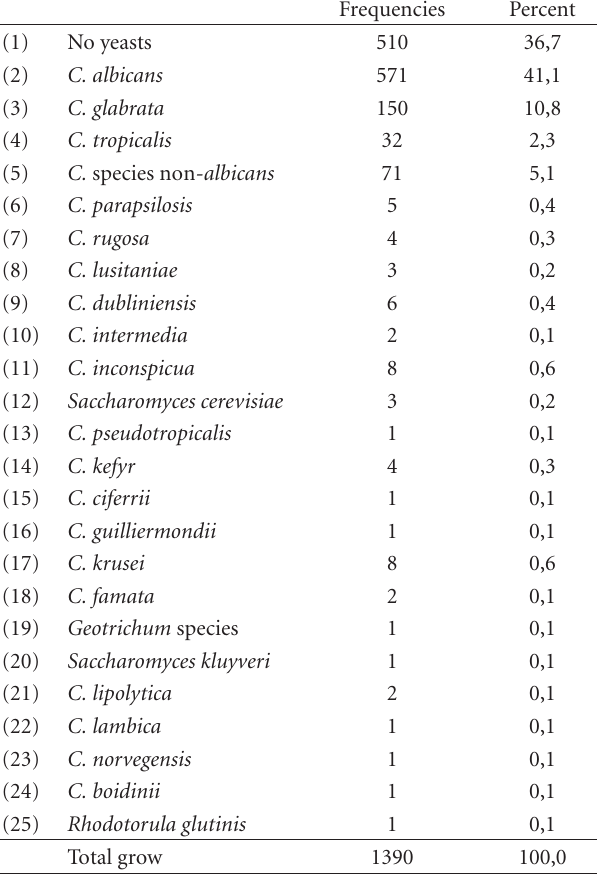
Table 6: Yeasts species isolated from palatal mucosa.